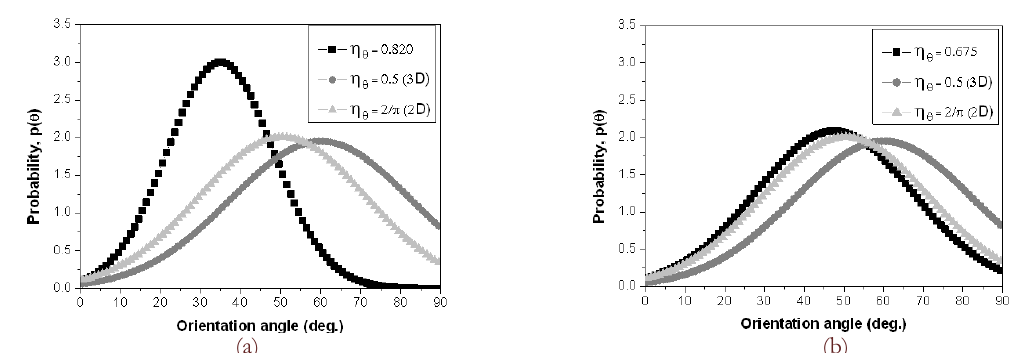
Figure 9: Predicted orientation profile: (a) θ = 0 ° and (b) θ = 90 ° .